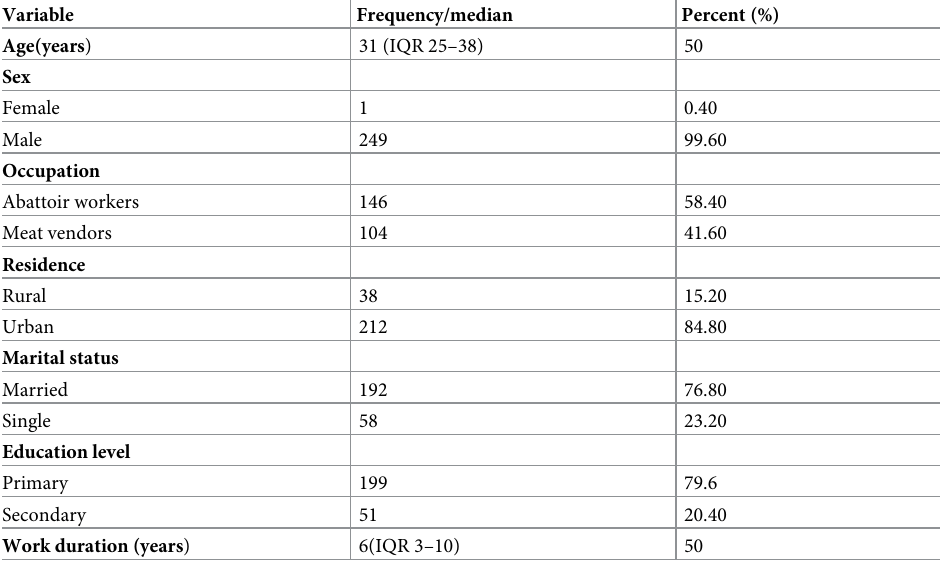
Table 1. Sociodemographic characteristics of the study participants conducted from May to July 2017.